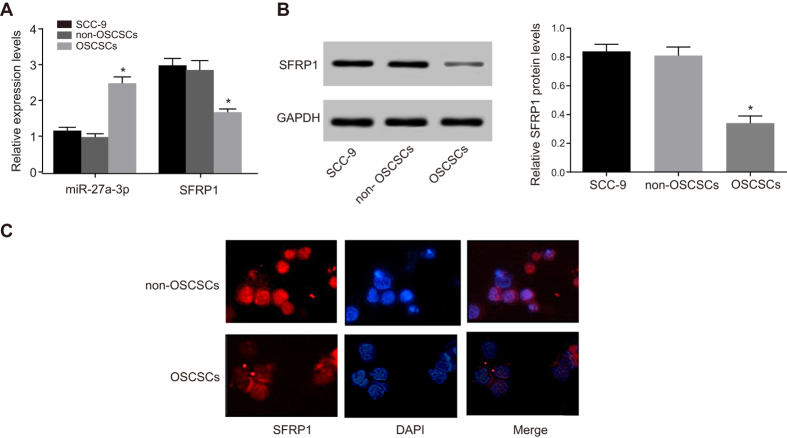
The expression of miR-27a-3p and SFRP1 in SCC-9 cells, non-OSCSCs and SCC-9 OSCSCs.(A) The mRNA expression of miR-27a-3p and SFRP1 in the three cell types detected by qRT-PCR. (B) The protein expression of SFRP1 in the three cell types detected by Western blotting; (C) SFRP1 expression in non-OSCSCs and OSCSCs detected by immunofluorescence. In A and B, *represents P < 0.05 comparisons with SCC-9 cells and non-OSCSCs. OSCSCs, oral squamous carcinoma stem cells; SFRP1, secreted frizzled-related protein 1; qRT-PCR, quantitative real-time polymerase chain reaction.